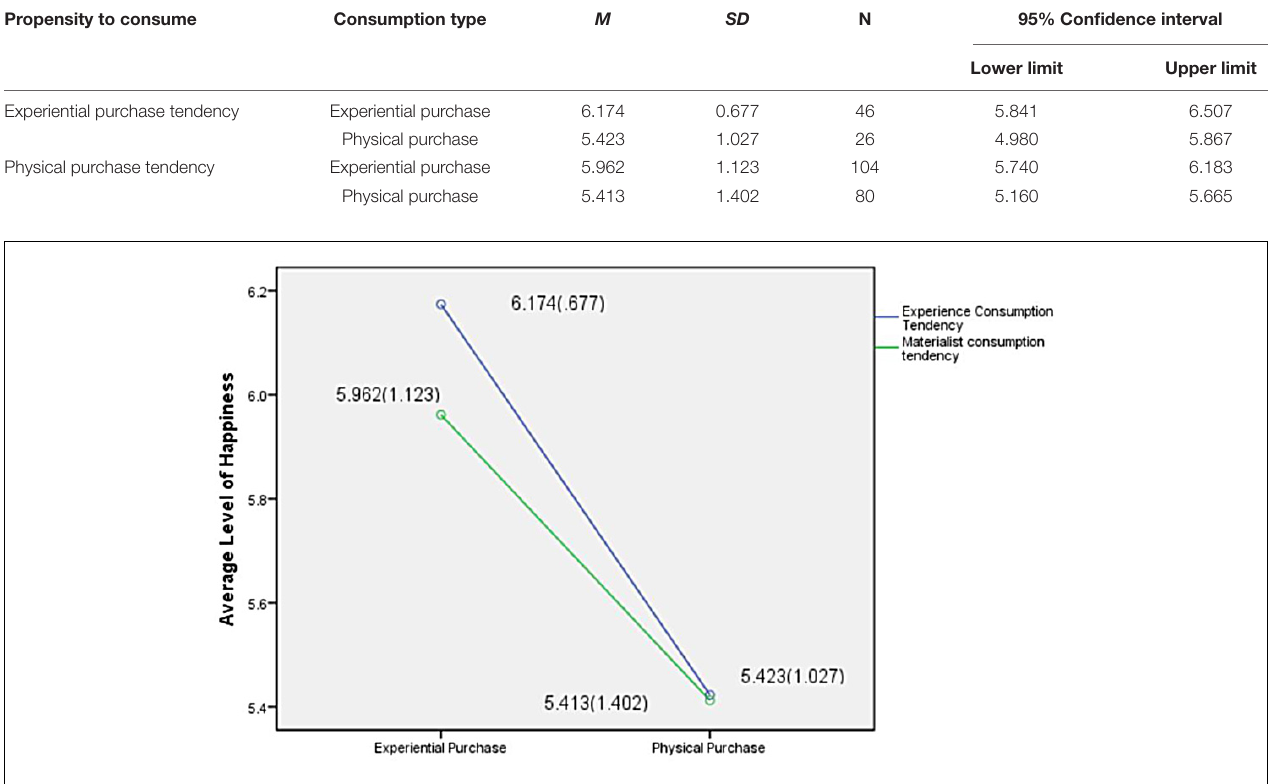
FIGURE 2 | Interaction between consumption tendency and consumption